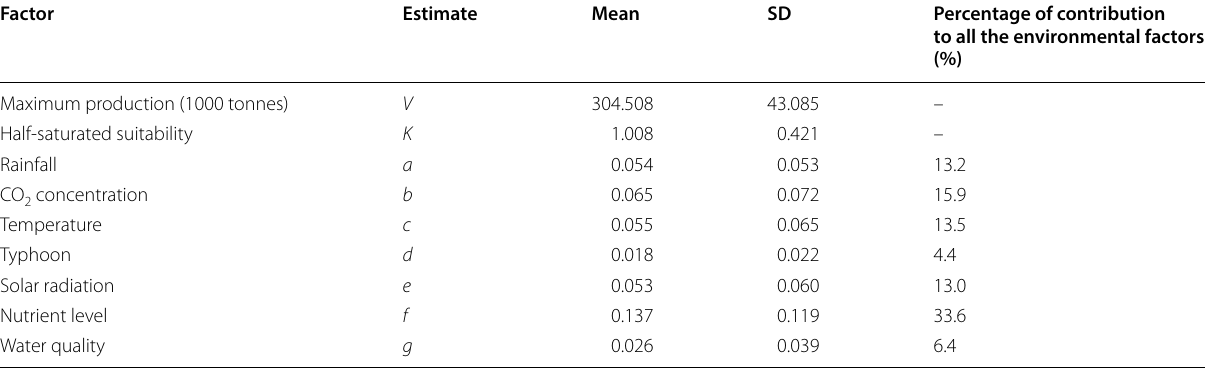
Table 1 The posterior mean and standard deviation (SD) of the Bayesian estimates